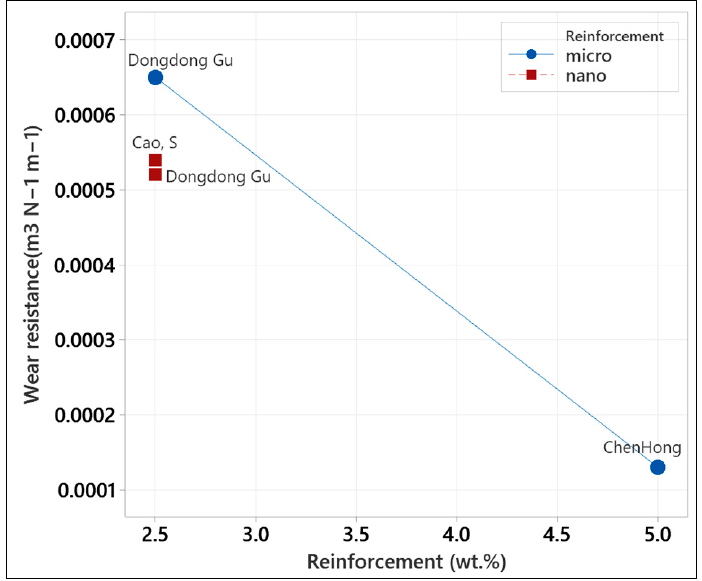
Figure 19. E ff ect of TiC reinforcement on wear resistance of DLD IN625 (data from [57–59]).